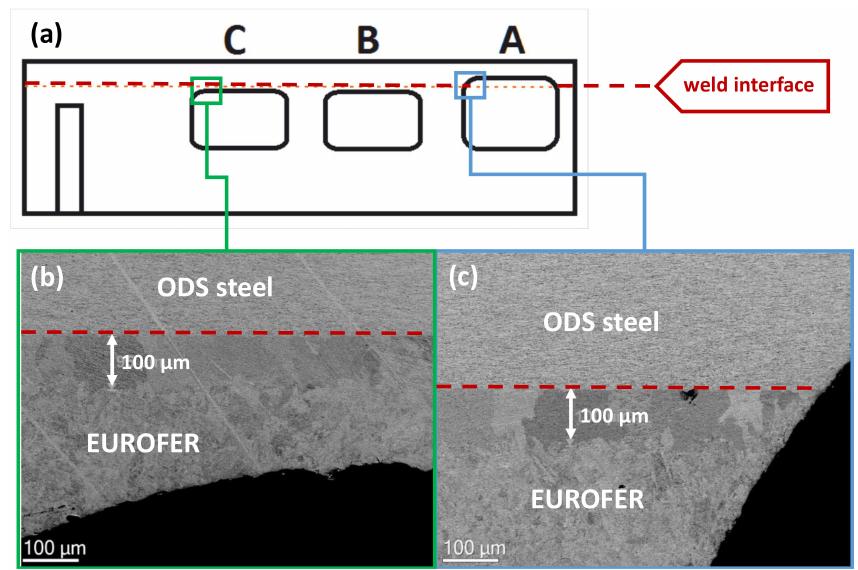
Figure 33. ( a ) Sketch indicating the cooling channel cross-sections A and C as well as the imaging areas; ( b ) BSE image acquired in the ODS steel/EUROFER interface area close to channel C. A distinct weld interface zone of about 100 µ m depth can be recognized; ( c ) BSE image of the corner area in the vicinity of channel C. In this case, also a clear weld interface zone of about 100 µ m has developed. Further, the intersection of the weld interface with the surface of the cooling channel (the intentionally created weak spot) does not show any defects.